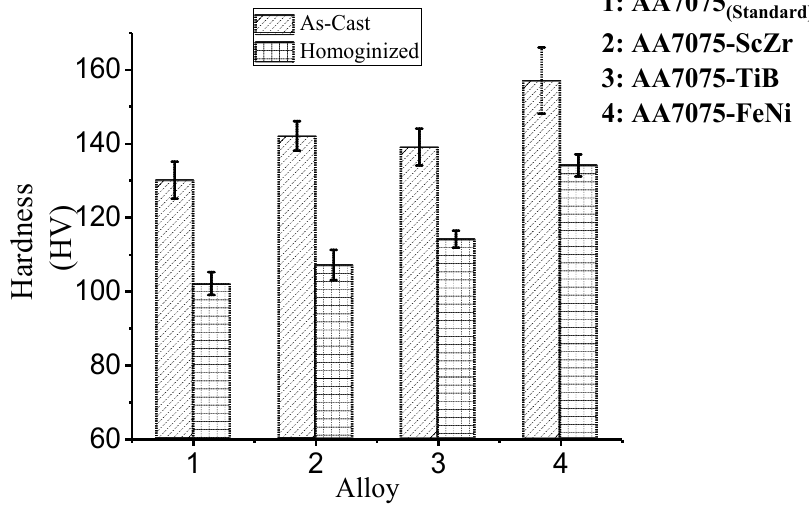
Figure 5. The Vickers hardness results of investigated alloy in as-cast and homogenized conditions.